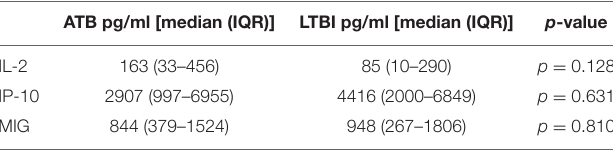
TABLE 2 | Concentrations in pg/ml of cytokines secreted by T cells in QuantiFERON (QFT) supernatants after ESAT-6, CFP-10 stimulation in 24 subjects with active tuberculosis (ATB) and 171 with latent TB infection (LTBI).